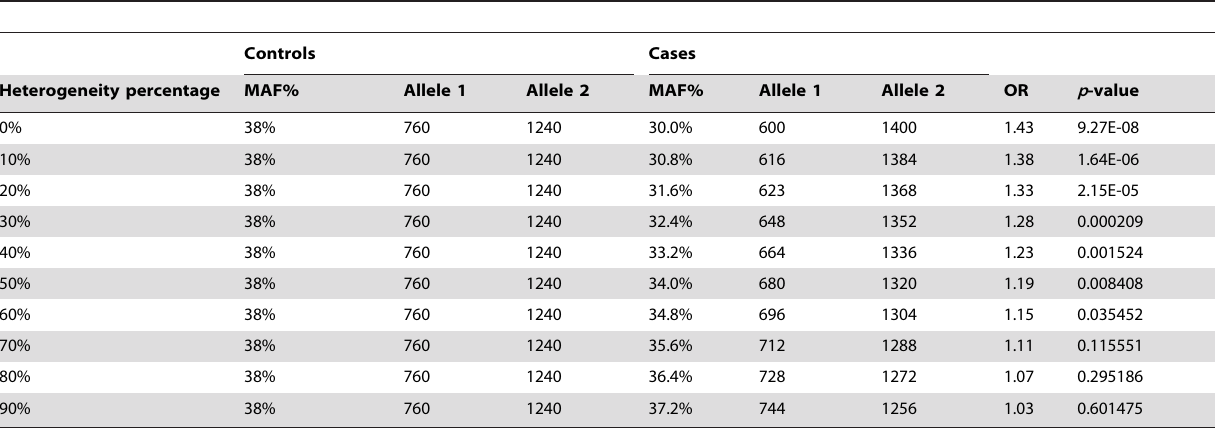
Table 8. A hypothetical example demonstrating the effect of heterogeneity (cases without the minor allele affecting disease)